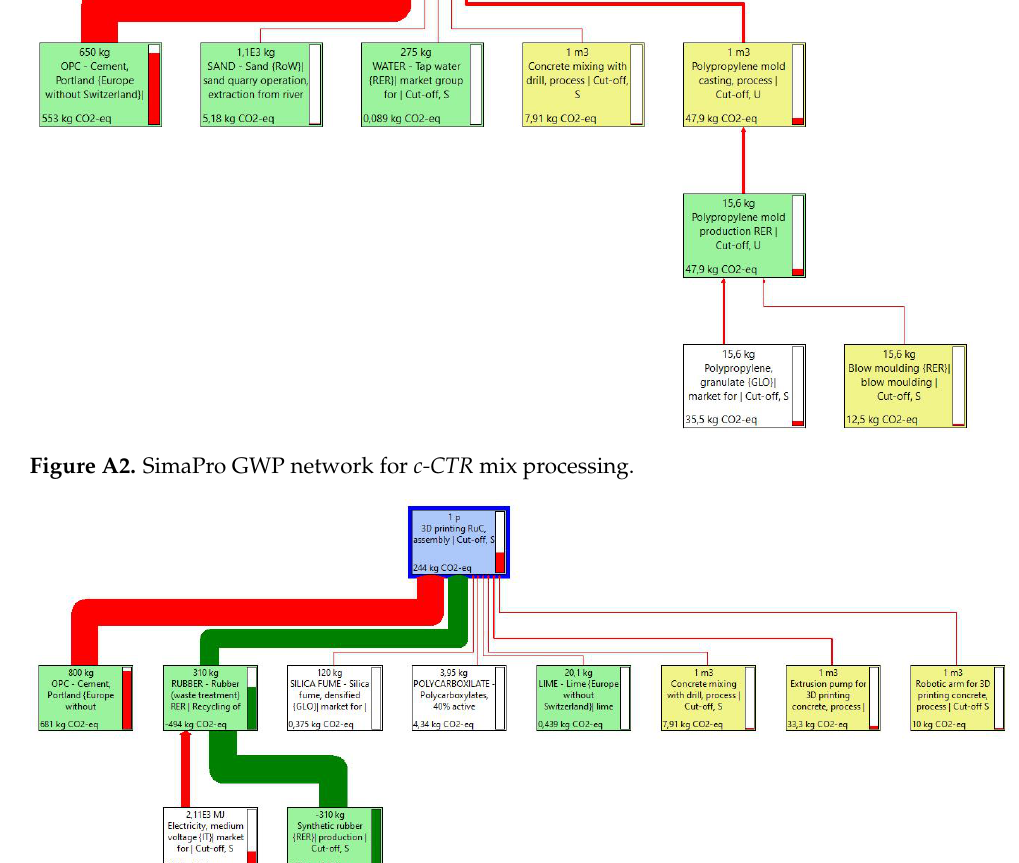
Figure A4. SimaPro GWP network for c-RuC mix processing.